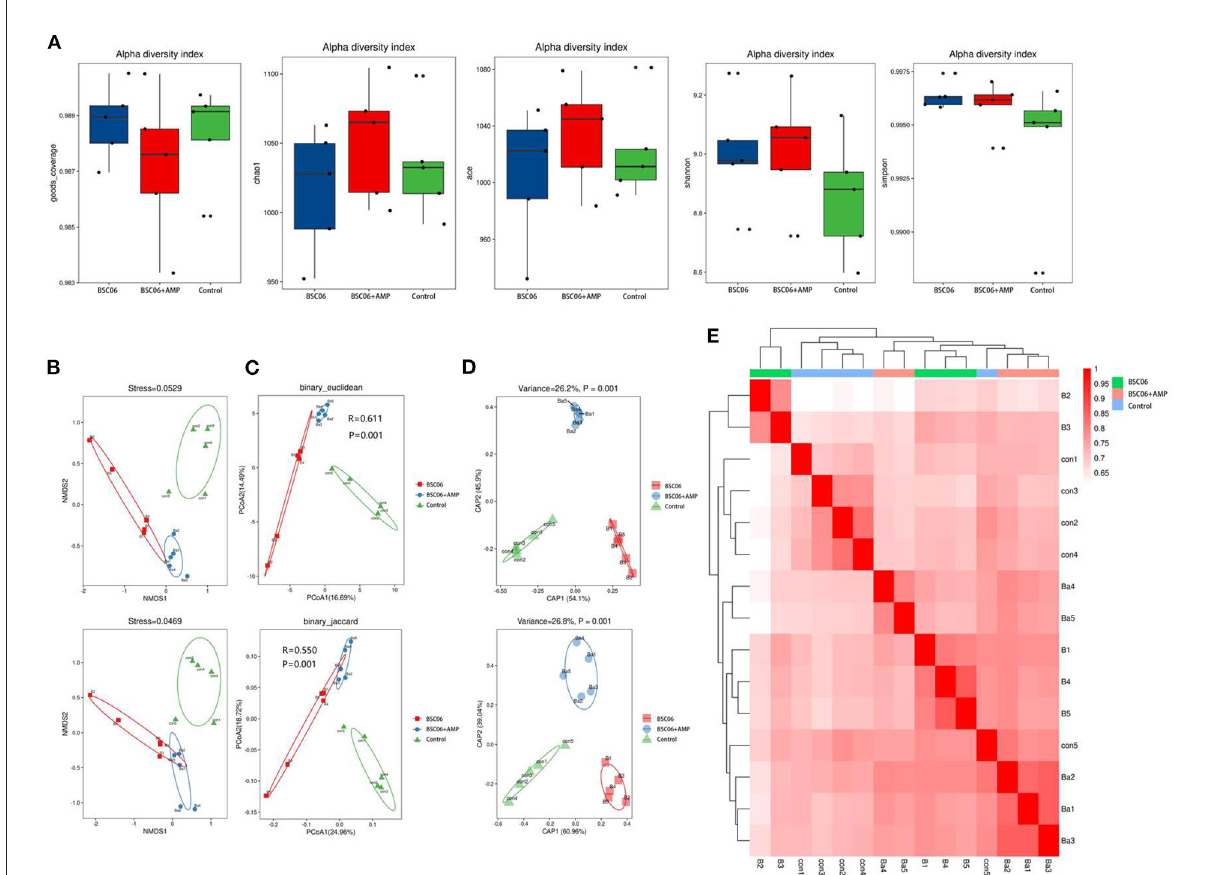
FIGURE7 Addition of BaSC06 and AMP alters microbial diversity in the cecum contents of laying hens. (A) Alpha diversity. Analysis of beta diversity using. (B) Non-metric multidimensional scaling (NMDS). (C) Principal co-ordinates analysis (PCoA). (D) Constrained PCoA (CPCoA). (E) Heatmap based on binary_jaccard analysis